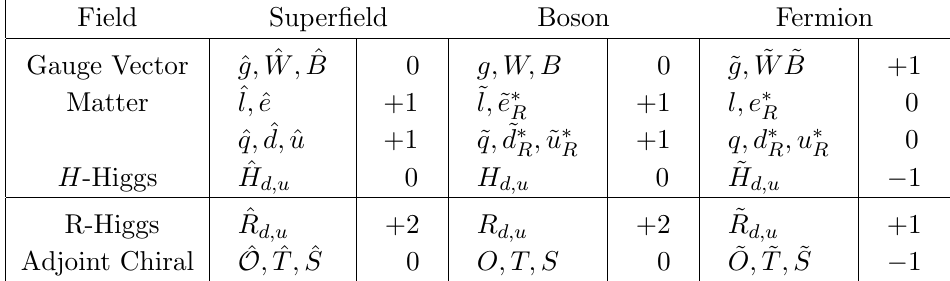
Table 1. The R-charges of the super(cid:12)elds and the corresponding bosonic and fermionic compo- nents. From ref.